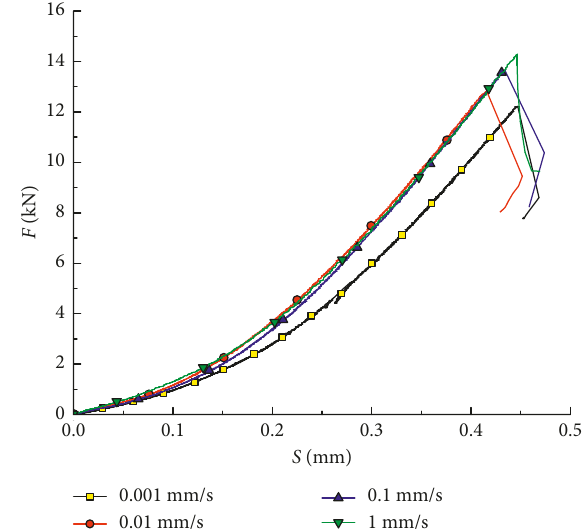
Figure 12: Load-displacement curves of specimens under arc loading.